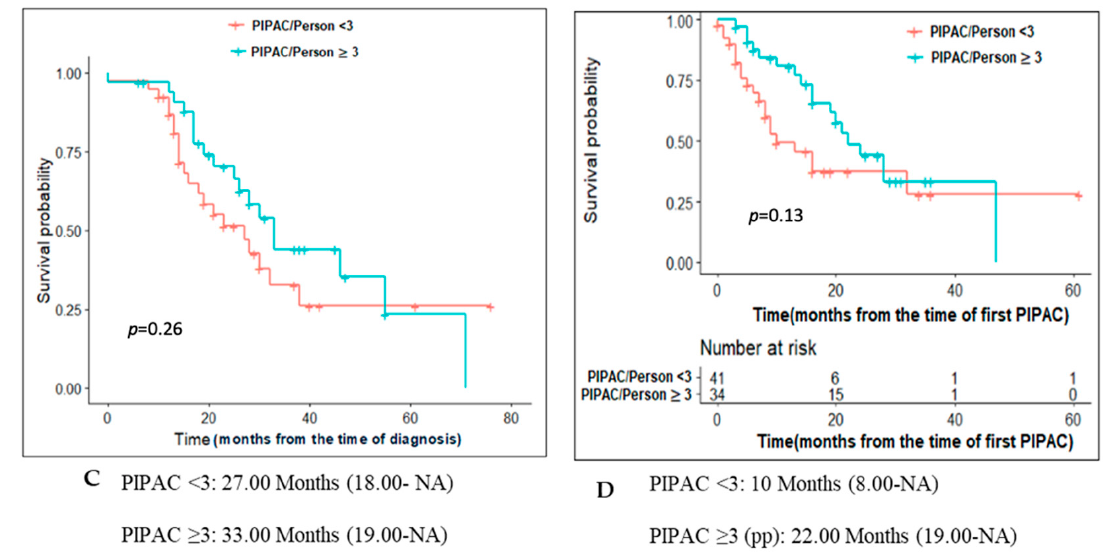
Figure 2. Survival of patients undergoing Pressurized IntraPeritoneal Aerosol Chemotherapy for peritoneal metastases of appendiceal origin. OS for the entire cohort from time of diagnosis ( A ) and first PIPAC ( B ). By protocol analysis for OS ( C ) from diagnosis and OS ( D ) from first PIPAC.